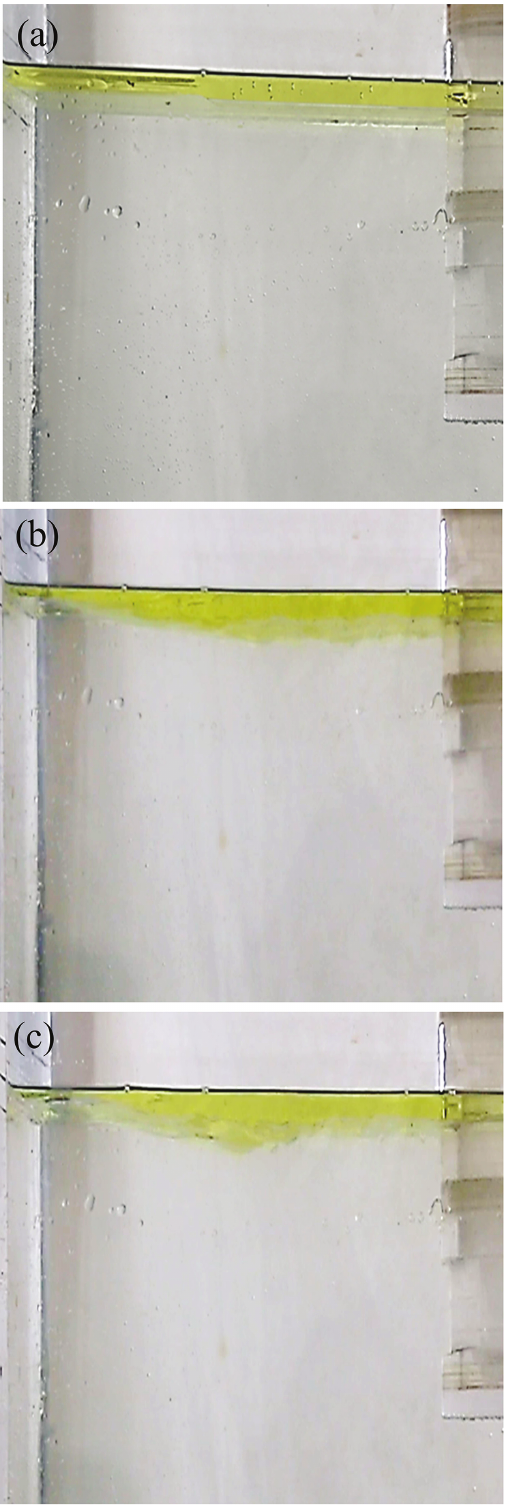
Figure 6: The simulation results of the fluctuation of the oil layer at different times: (a) 0.2 s, (b) 0.4 s, and (c) 0.6